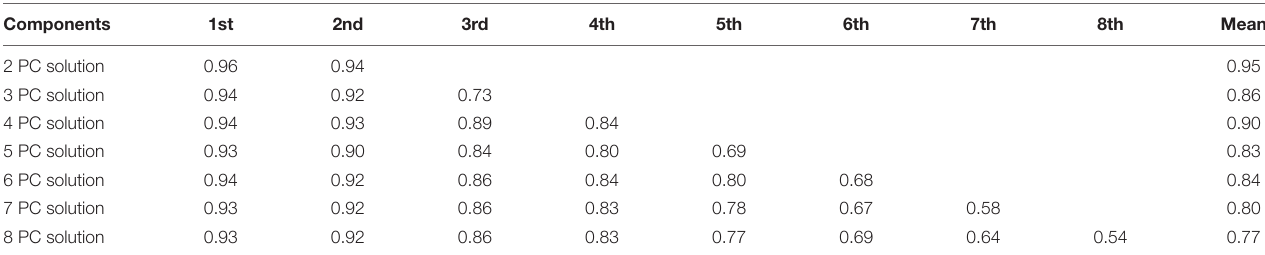
TABLE 1 | Mean congruence coefficients of 500 within-sample randomly split between-subjects PCAs of 321 ipsatized sport adjectives ( N = 555) using orthogonal Procrustes rotation of up to eight components. Components